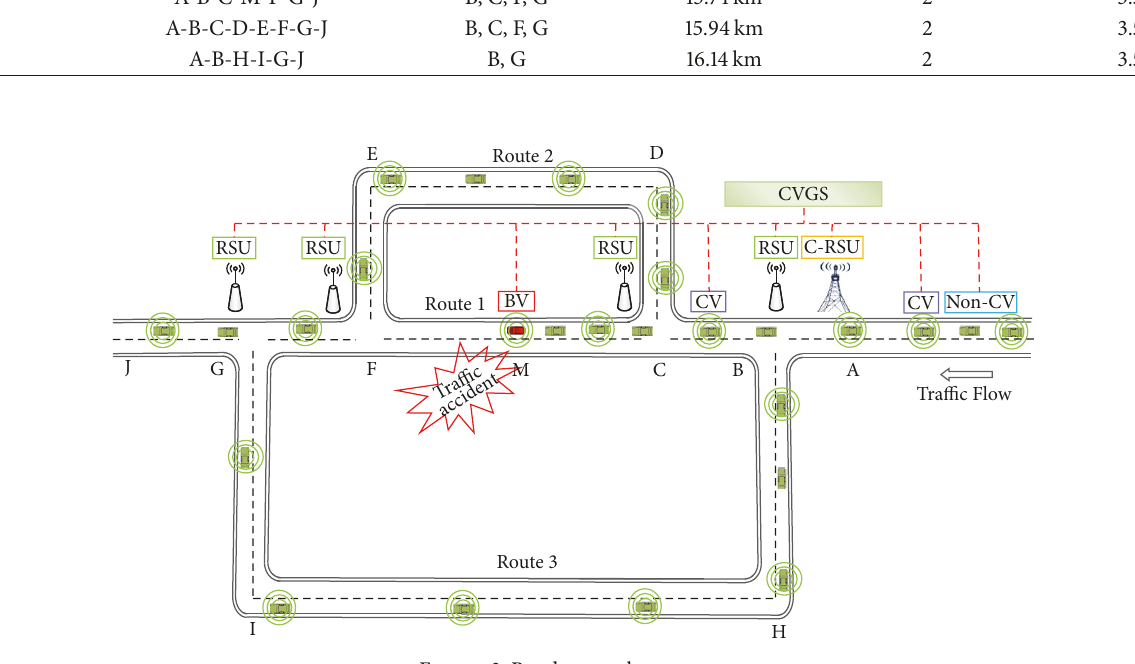
Figure 3: Road network structure.